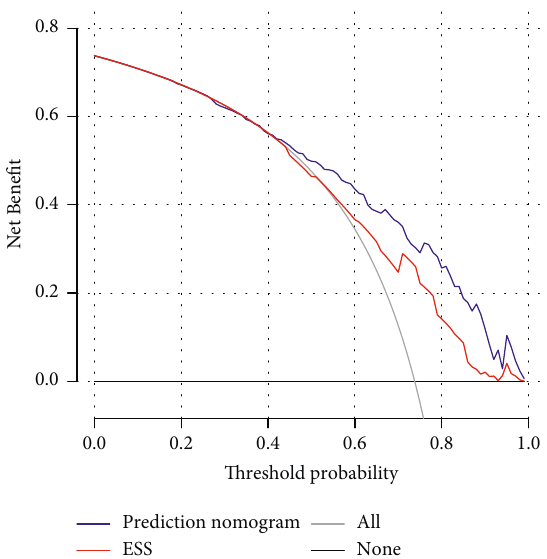
Figure 5: Decision curve analysis for the nomogram for predict OSA in validation set. Notes: The y -axis measures the net benefit. The blue line represents the OSA risk nomogram. The red line represents the ESS prediction risk of OSA. The thin solid line represents the assumption that all patients are non-OSA. Thin thick solid line represents the assumption that no patients are non-OSA. The decision curve showed that if the threshold probability of a patient and a doctor is more than 42%, using this nomogram for OSA in the current study to predict OSA risk adds more benefit than the ESS, intervention-all-patients scheme, or the intervention-none scheme. OSA, obstructive sleep apnea; ESS, Epworth sleepiness